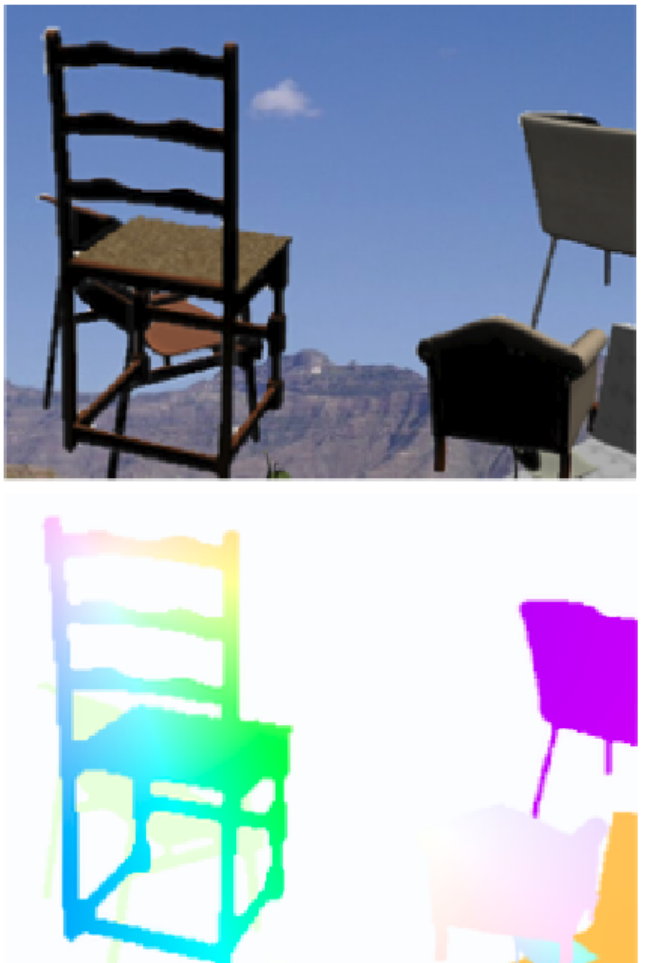
Figure 14. An example of an image ( up ) and its dense optical flow ground truth ( down ) from the flying chairs